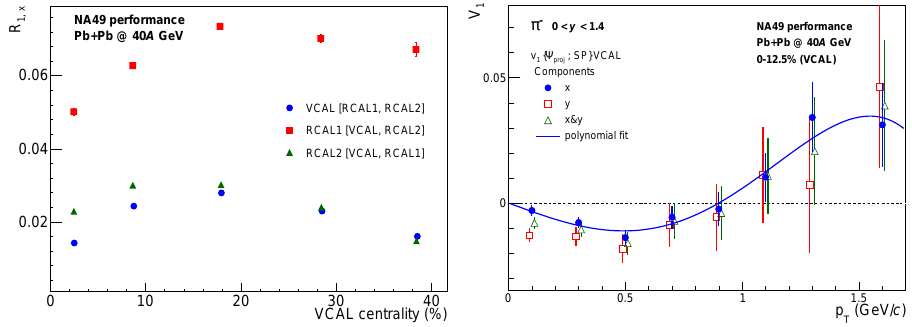
Figure 4. Left: Resolution R 1 , x of spectator symmetry plane angles estimated with VCAL, RCAL1 and RCAL2. Right: Directed flow ( v 1 ) of negatively charged pions for central collisions measured relative to VCAL using x and y components of q and Q vectors